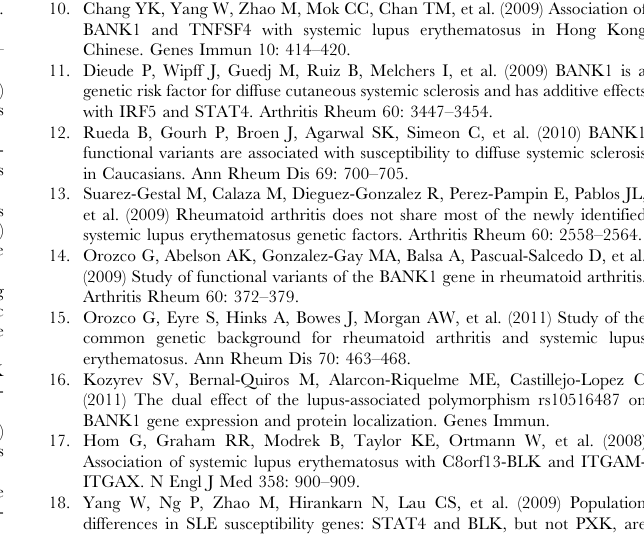
Figure S1 Prisma Flow diagram summarizing how the meta-analysis was